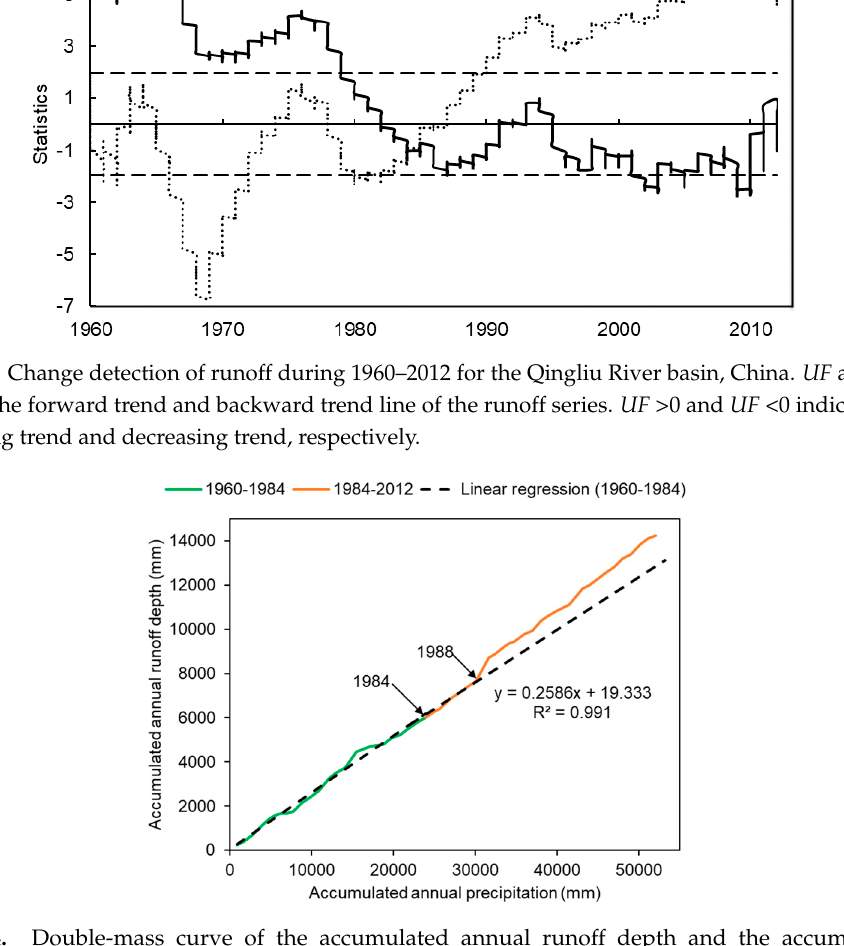
Figure 4. Double-mass curve of the accumulated annual runoff depth and the accumulated annual 273 precipitation. 274